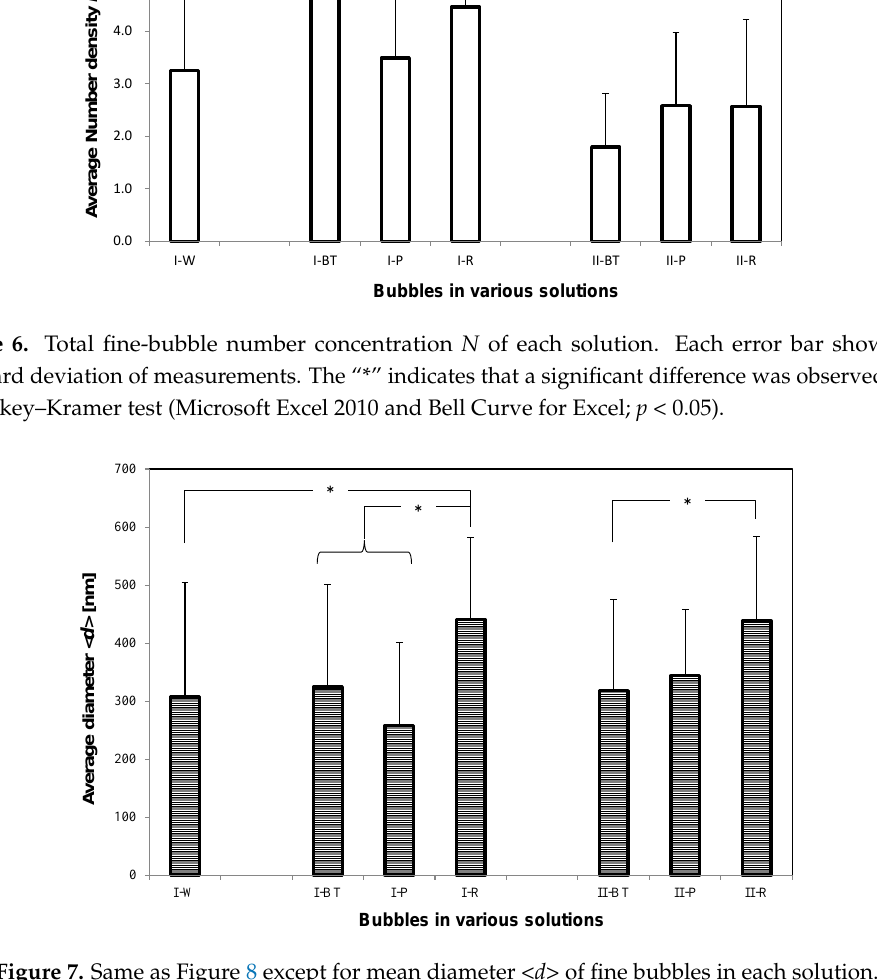
Figure 7. Same as Figure 8 except for mean diameter < d > of fine bubbles in each